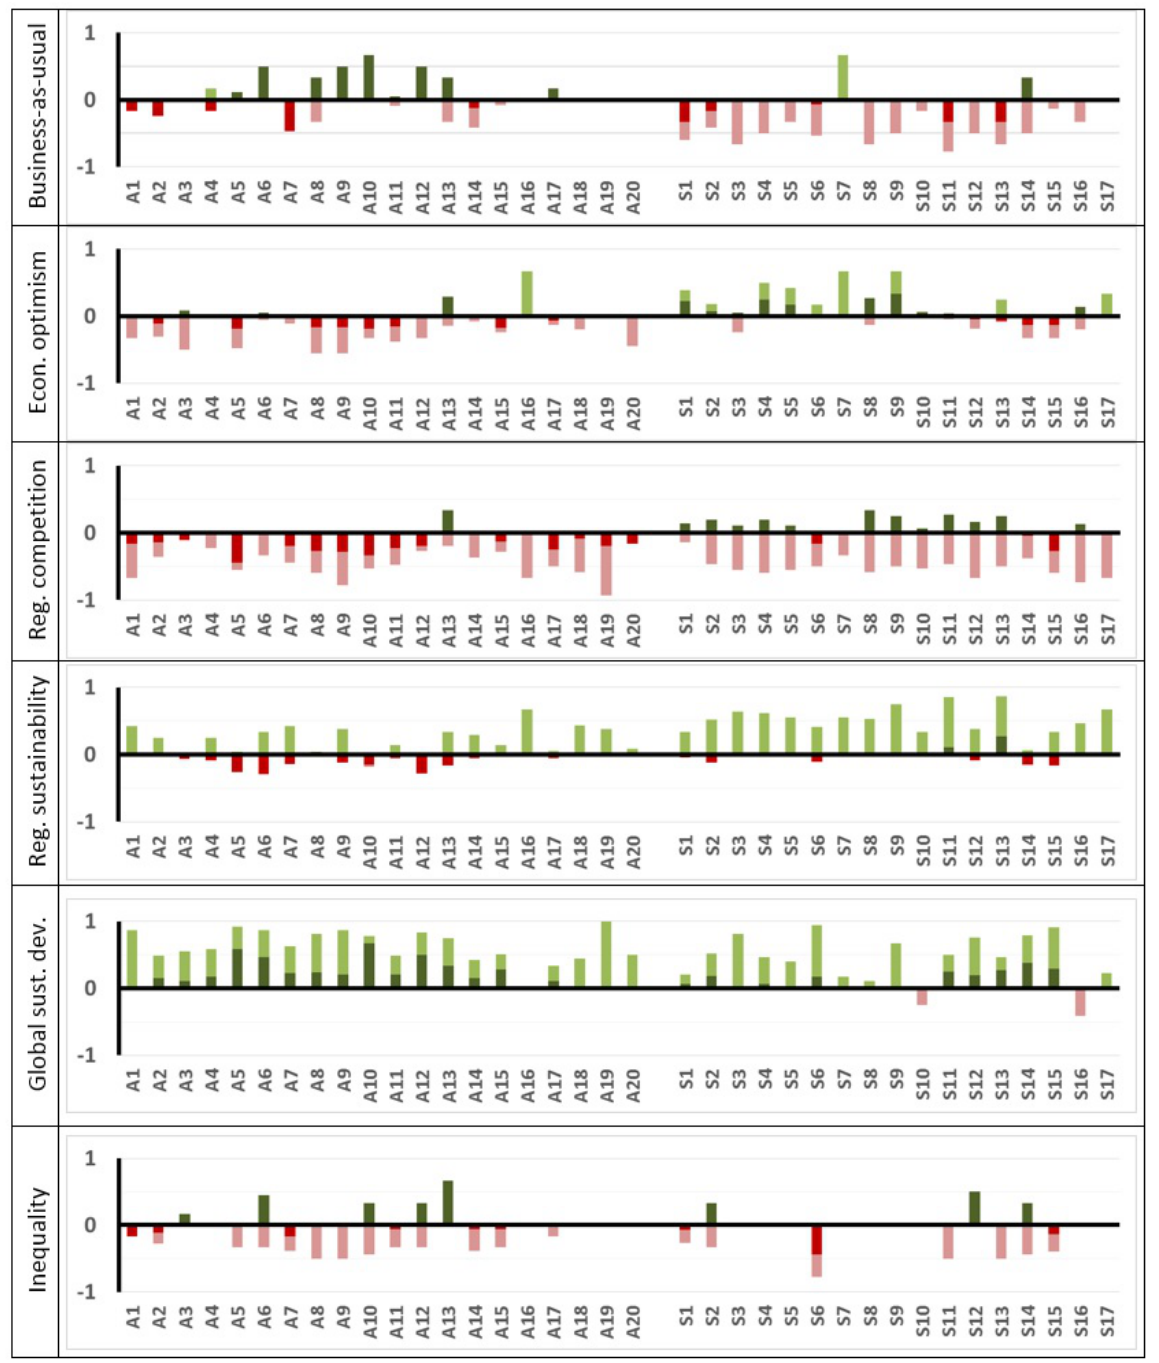
Fig. 3 . Extent to which Aichi targets and sustainable development Goals (SDGs) may be reached under the different scenario archetypes for Europe and Central Asia. The height of the bars reflect the extent to which Aichi targets and SDGs may be reached in a relative scale from 1 (completely reached) to -1 (completely failed). Red (below the line) indicates relative failure in achieving targets/goals; green (above the line) indicates relative success in their achievement. Darker shaded bars are supported with evidence from ≥ 10 papers; lighter shades from < 10 papers. Note that SDGs and Aichi targets with no bars, i.e., a zero value, mean that there was no evidence from the literature to suport that information. Also note that the scenario archetype timeframes extend beyond those of the Aichi targets and SDGs, ranging from 2030 to